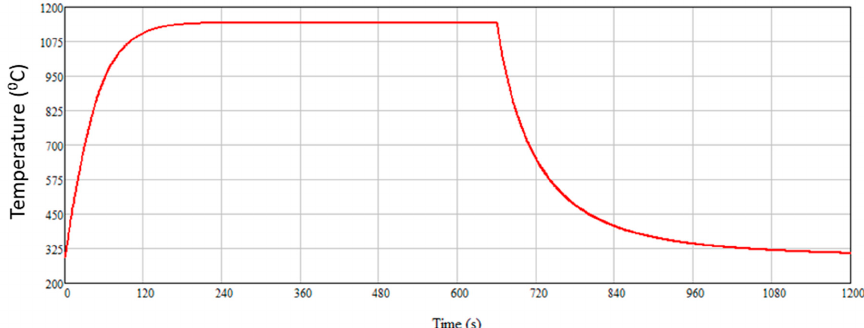
Figure 11. Maximum temperature variation in the first shield.